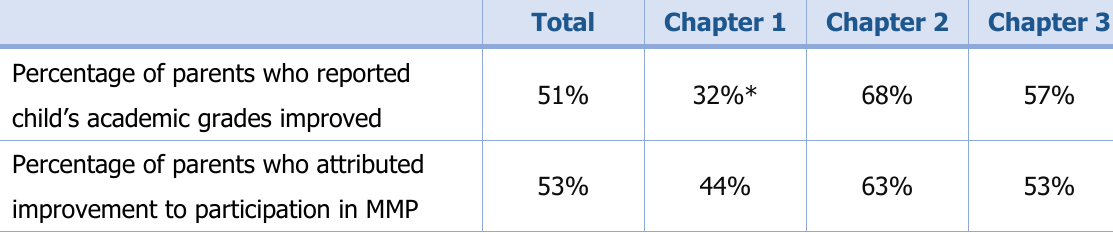
Table 2. Percentage of Parents Reporting Academic Improvements by Chapter Percentage of parents who